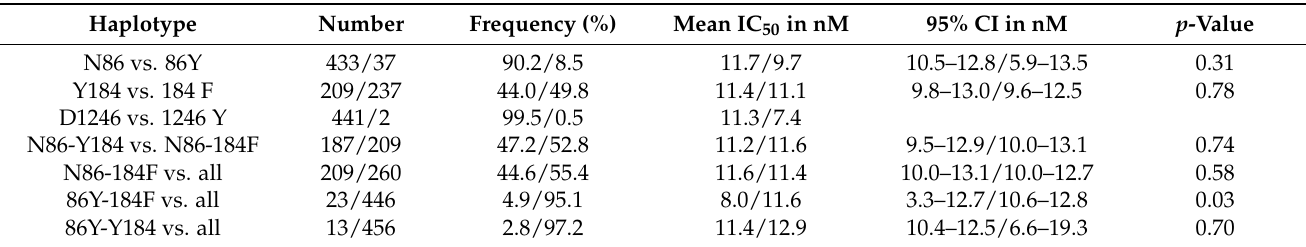
Table 2. Association between the Pfmdr1 haplotypes analyzed among 480 clinical P. falciparum African isolates and ex vivo susceptibility to methylene